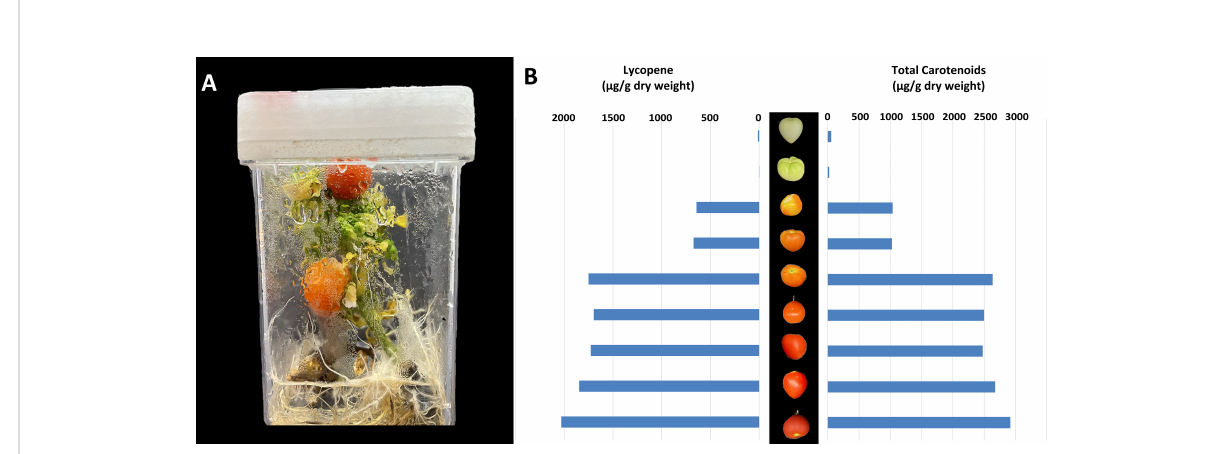
FIGURE 2 Production and analysis of in vitro MicroTom fruit. Indicated are (A) example of in vitro MicroTom fruit production system, and (B) tissue culture produced MicroTom metabolite pro fi